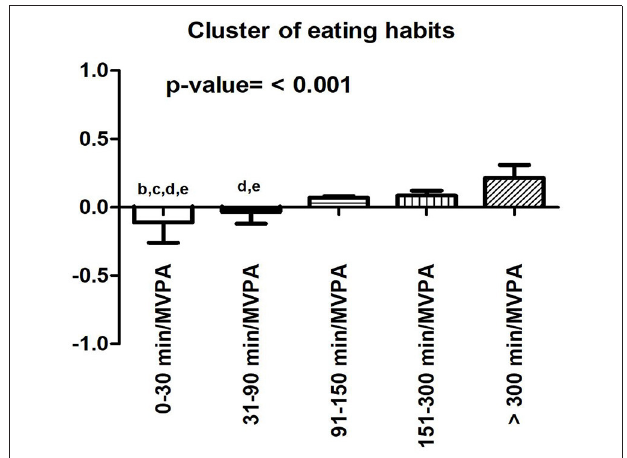
FIGURE 1 | Comparison of the food cluster during quarantine in COVID-19 in inactive and active participants. b, difference with 31–90 min/MVPA; c, difference with 91–150 min/MVPA; d, difference with 151–300 min/MVPA; e, difference with > 300 min/MVPA. Adjusted by sex, age, education level, social isolation and